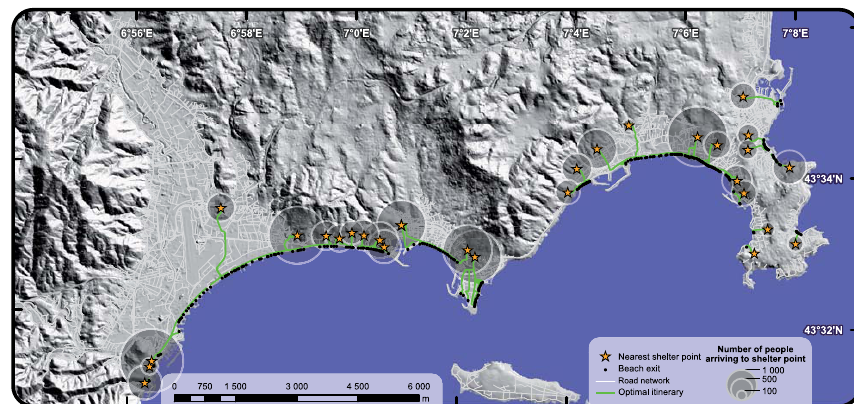
Fig. 8. Potential load for nearest shelter points.